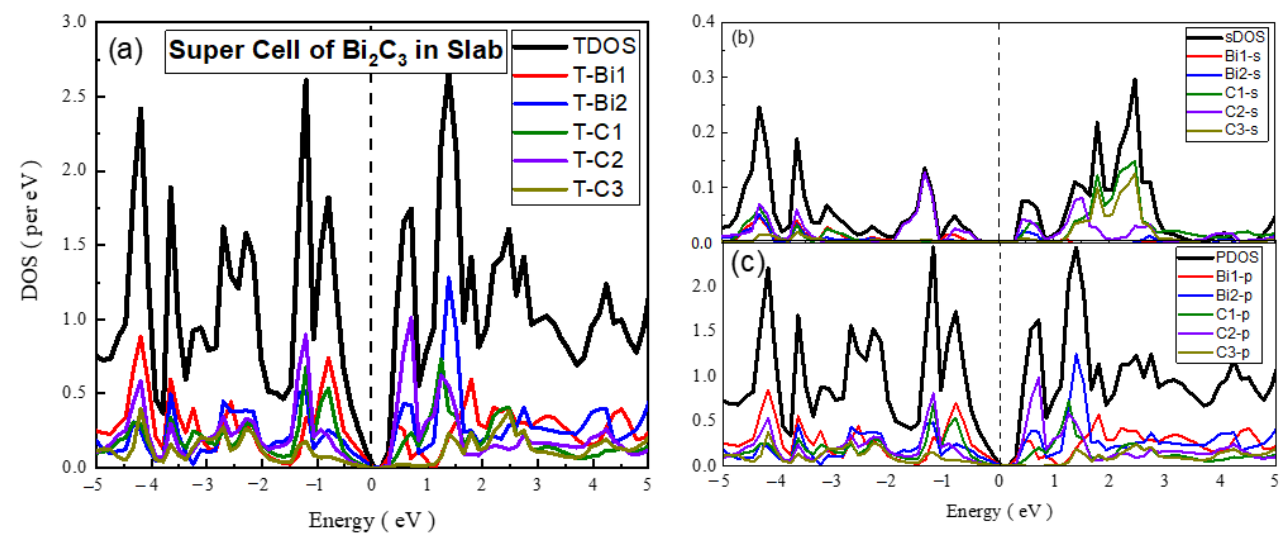
Figure 8. The calculated total density of states (TDOS) and partial density of states for the mentioned atoms in Bi 2 C 3 super cell ( a ) TDOS of slab ( b ) s-DOS of slab ( c ) p-DOS of slab. The Fermi level was adjusted at 0 eV.